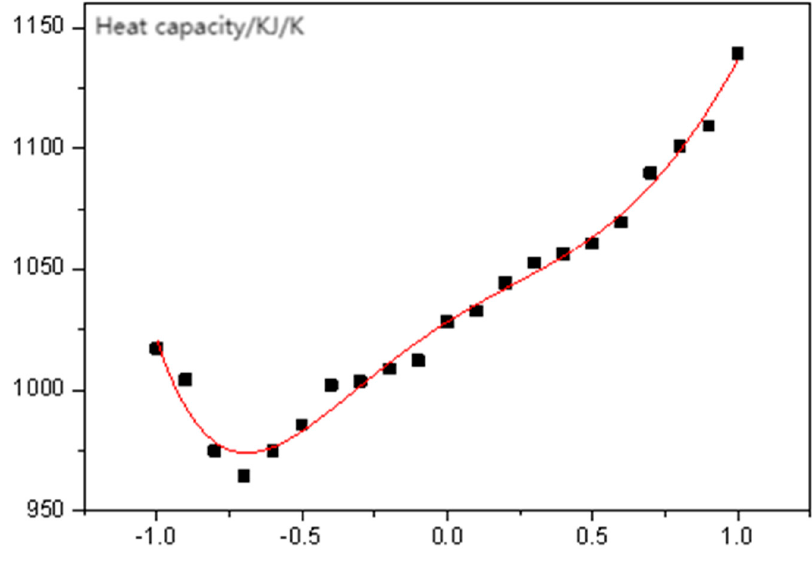
Proposed and interval. H fitting curve. Figure 3. System thermal equivalent H E fitting E